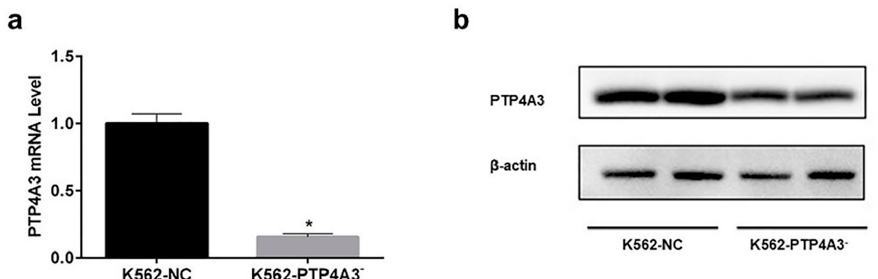
Figure 4. Establishment of PTP4A3 down-expression K562 cell line. ( a ) The expression of PTP4A3 at mRNA level was measured with real-time quantitative PCR. ( b ) The expression of PTP4A3 was measured with western blot. *: p < 0.05, compared with the K562-NC cells.